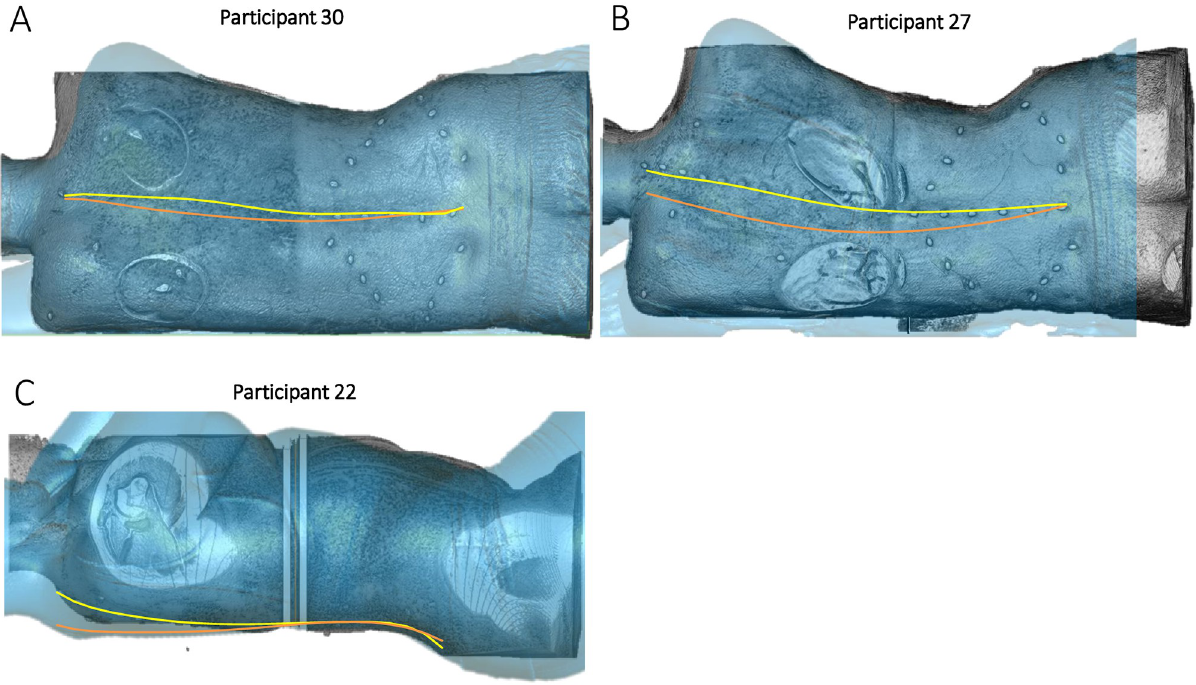
Fig 8. Comparison of the MRI 3D volume render and 3DSS. Comparison of FMP (yellow) and 3MP contours (orange) overlayed on a 3D volume rendering of the MR images (in Amira) shown in grayscale, with the 3DSS shown in transparent Blue (from Geomagic). In comparison to the 3DSS, participant 30 (A), shown in the coronal view, shows elevation of the right shoulder. Participant 27 (B), shown in the coronal view, shows more lumbar lateral flexion in the MRI. Participant 22 (C) shown in the sagittal view, demonstrates more lumbar lordosis and thoracic kyphosis.